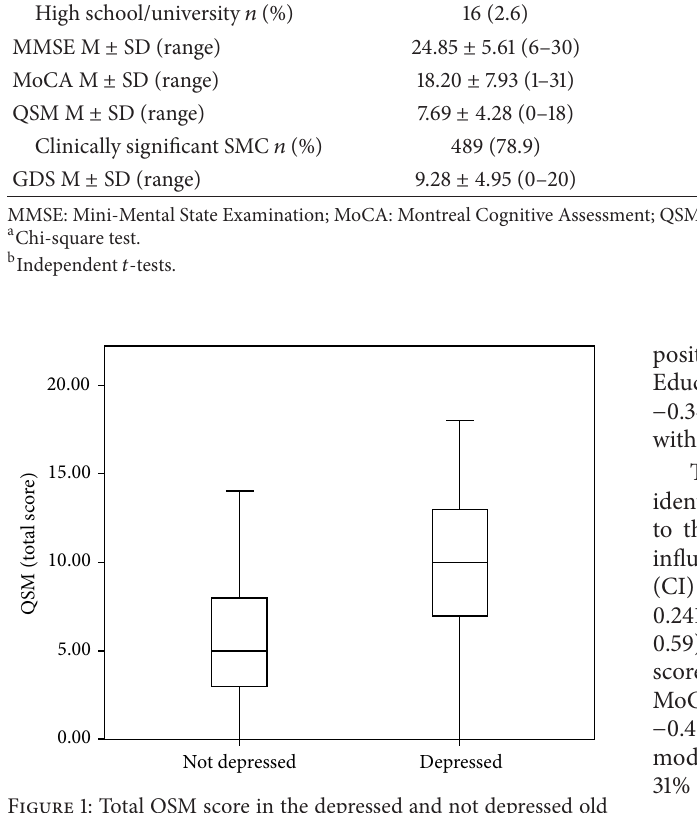
Figure 1: Total QSM score in the depressed and not depressed old